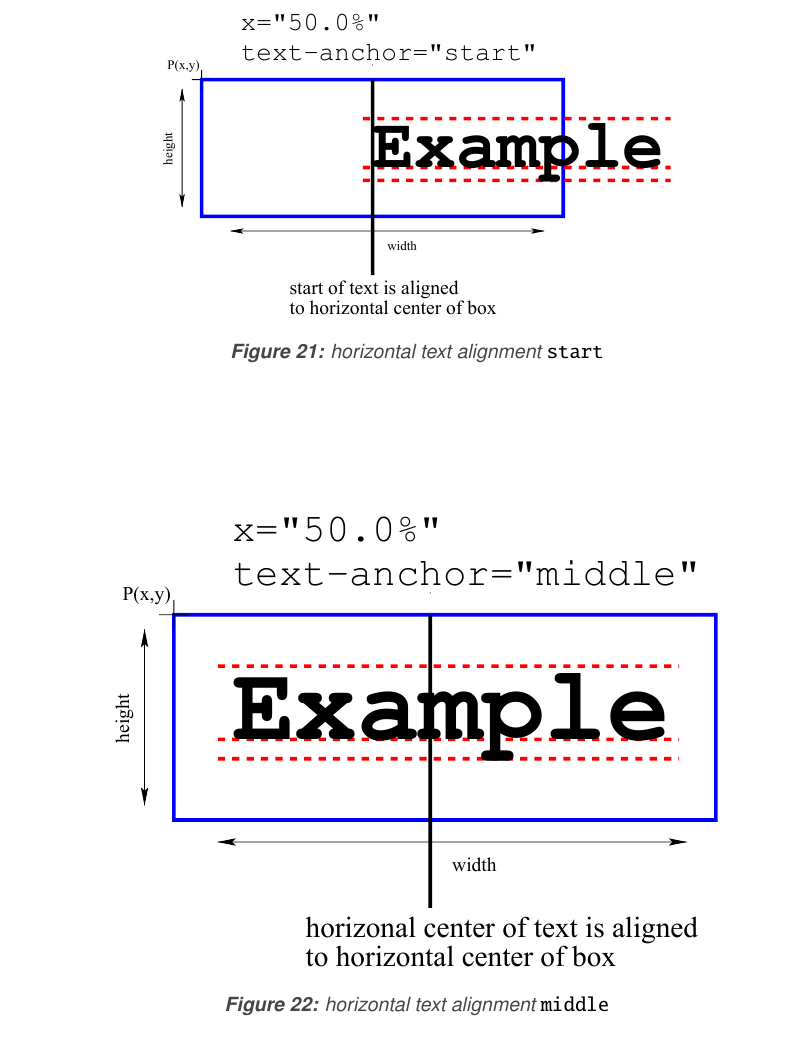
Figure 22: horizontal text alignment